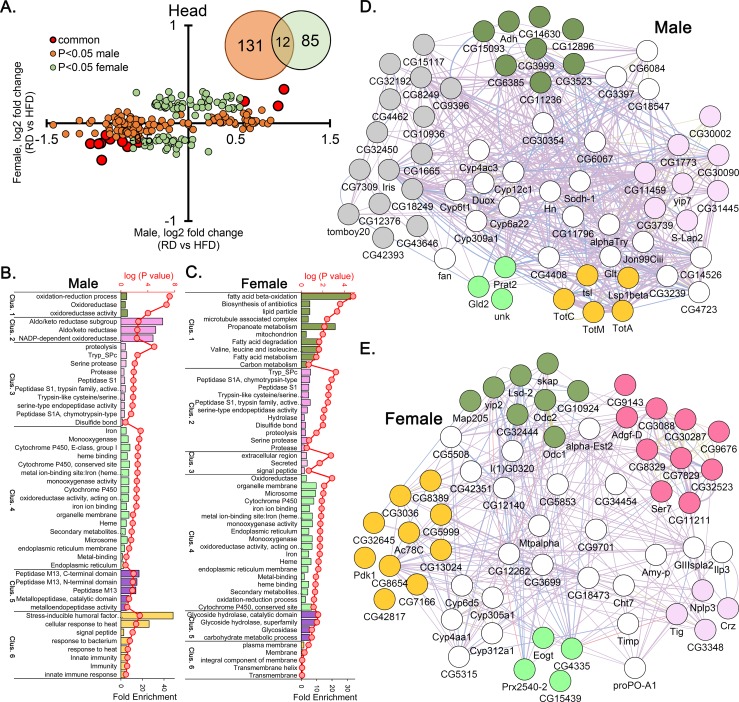
Transcriptional change in the heads leading to HFD-induced sex specific pathway enrichment.(A) Relative fold change between male and female heads after HFD treatment. Insert; Venn diagram depicts the number of differentially expressed genes shared between males and females head. Functional Annotation Clustering at medium stringency in the heads of male-specific (B) and female-specific (C) genes. (D) Network analysis depicting the individual genes within each cluster interacting in both within as well as between clusters for male (D) and female (E). Similar color coding for bar and network plots. White circles in network plots are genes shared between two or more clusters.